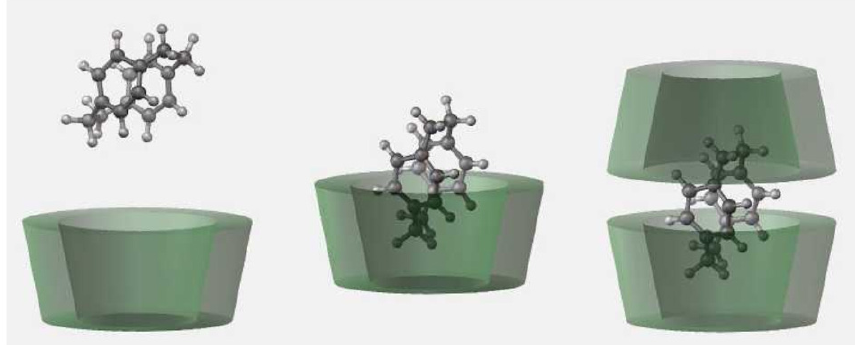
Figure 1. Schematic views of free [2.2]paracyclophane and cyclodextrin (left) and their 1:1 (middle) and (1:2) (right)